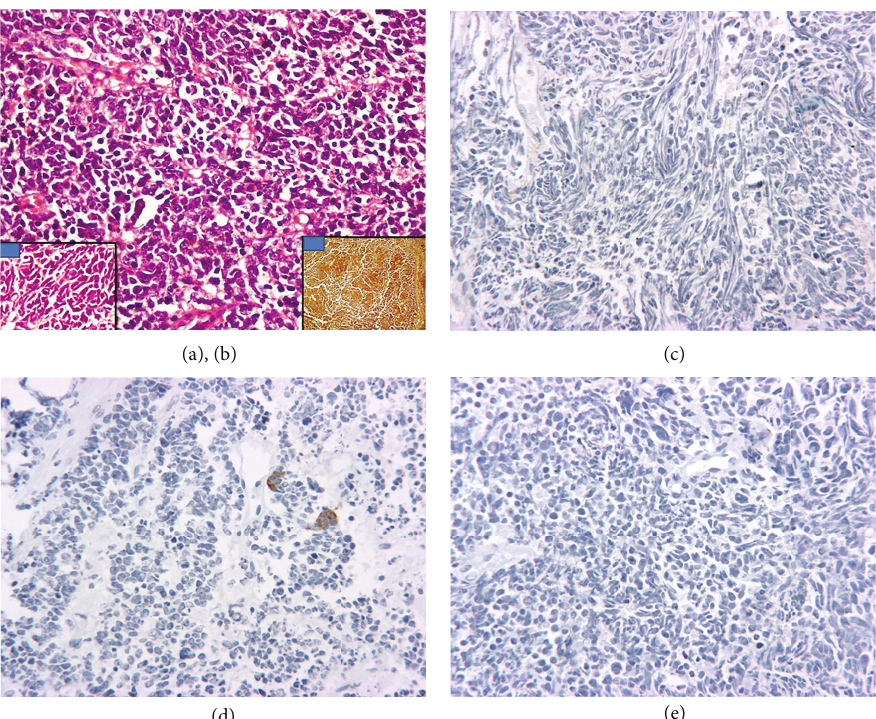
Figure 3: ((a) and (b)) Microphotograph from the prostate shows a tumor present in sheets with hyperchromatic nuclei and scanty cytoplasm consistent with morphology of small cell carcinoma H&E × 200. Insets show (a) tumor cells at high power which show moulding H&E × 400 and (b) strong positivity with neurone specific enolase IHC × 100. (c) Immunohistochemistry showing vasopressin negativity. (d) Immunohistochemistry for the carrier protein neurophysin is negative. (e) Immunohistochemistry for prostate specific antigen (PSA) is conspicuously negative suggestive of dedifferentiated tumor.